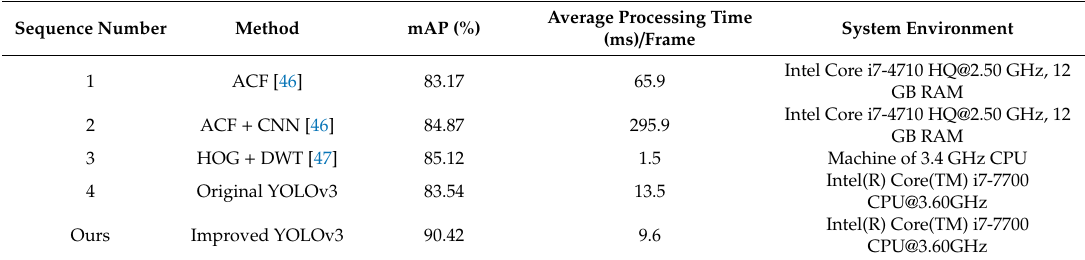
Table 7. The comparison of statistics in algorithm performance based on the INRIA person